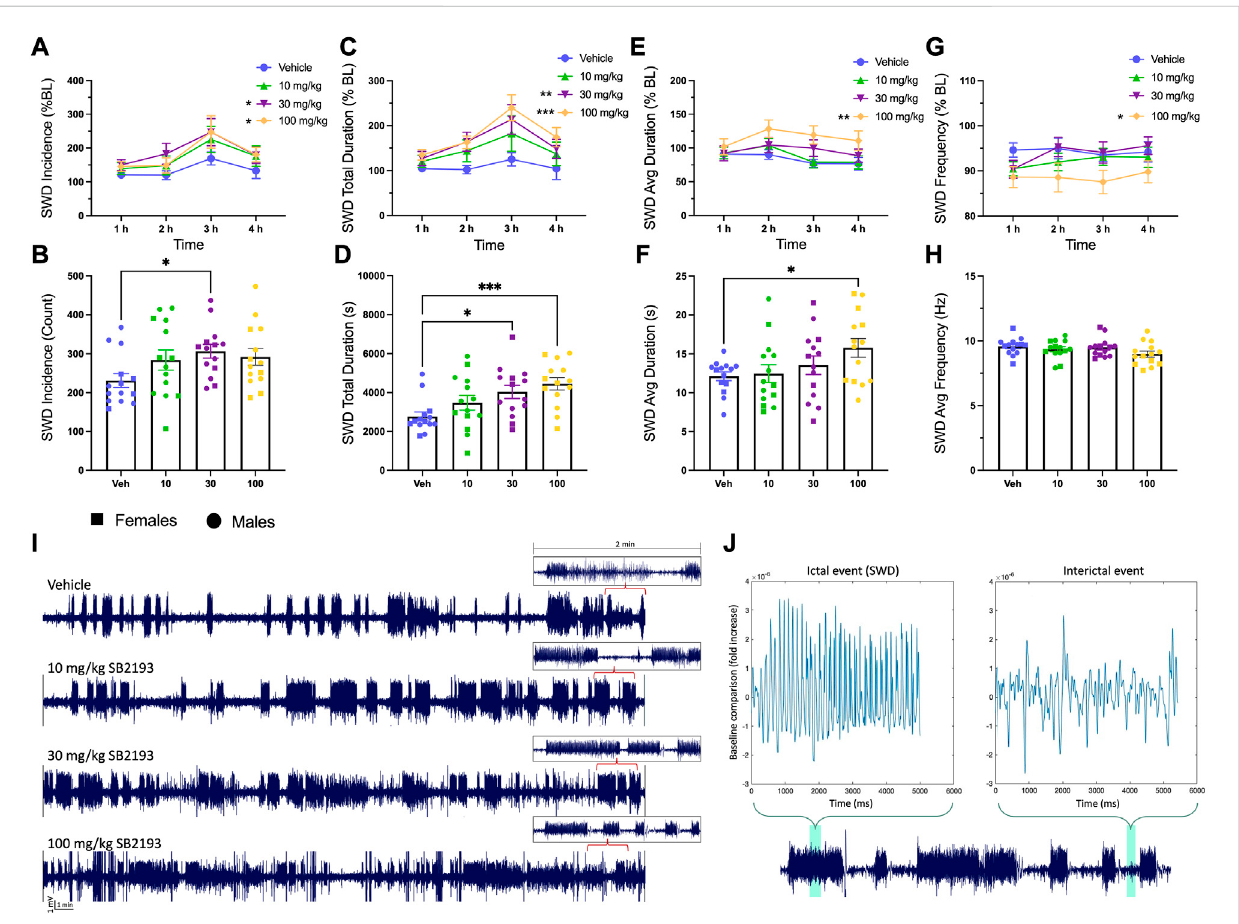
FIGURE 8 SB2193 increased spike and wave discharge (SWD) incidence and duration in GAERS (males: n = 9; females: n = 5). SB2193 treatments (Veh, 10, 30, 100 mg/kg) were administered (i.p.) ~20 min prior to EEG recordings (4 h). SWDs are reported as the normalized percentage change from baseline (A, C, E, G) and raw data sampled over the 4 h recording window (B, D, F, H) . Representative EEG traces show 30 min samples from a single rat following the four treatments; insets depict zoomed-in 2 min traces (I) . SWD event durations were assessed semi-autonomously using Matlab (script = “ EEG SeizureAnalyzer ” )andcon fi rmedbyanexperimenterbasedonpre-establishedcriteria(7 – 12 Hz;burstactivity > 3xbaselineforatleast > 0.5 m). (J) Panels show a Matlab-produced SWD event (top left) alongside an interictal event (top right) and events are highlighted within an expanded 2 min sample trace